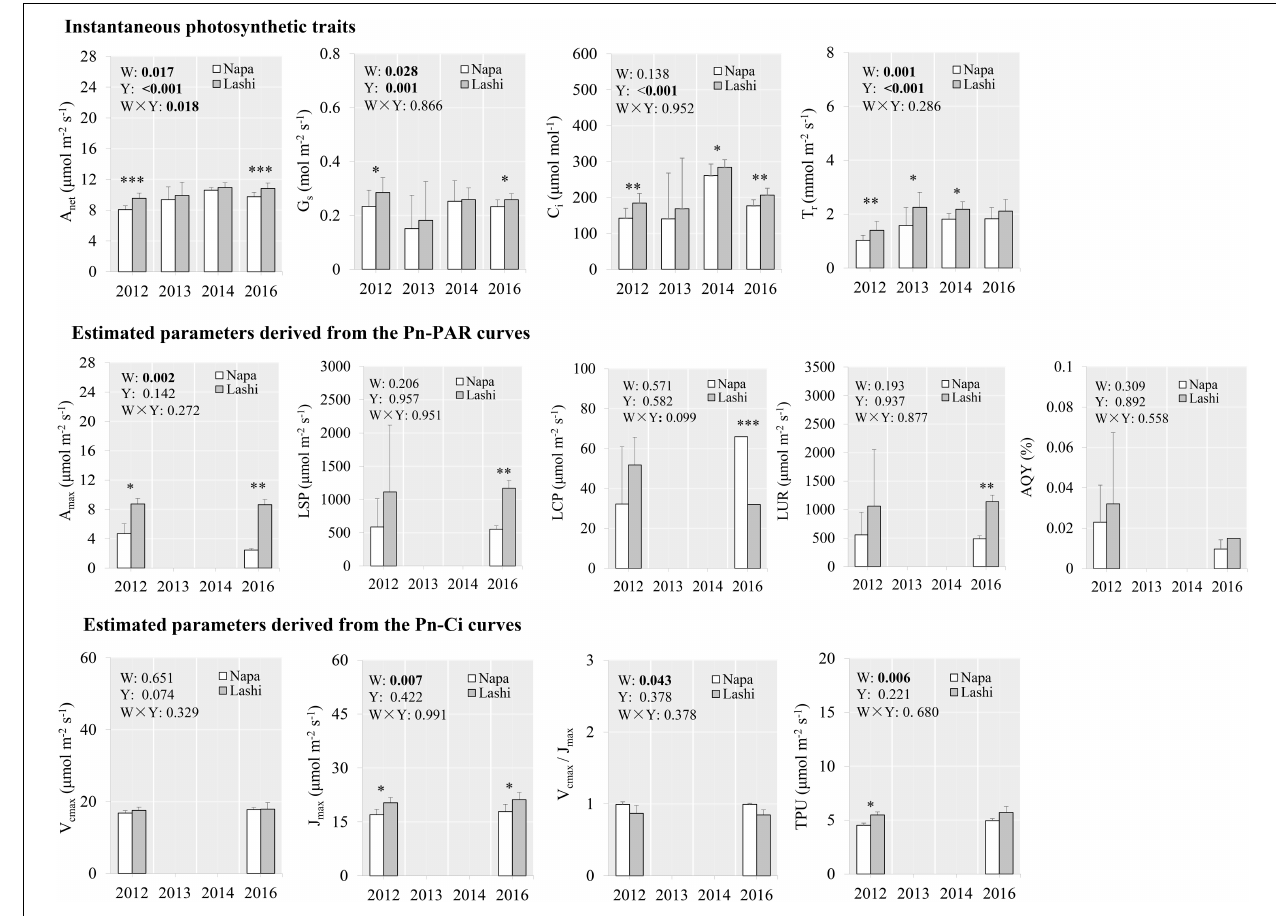
FIGURE 5 | Photosynthetic traits of S. tabernaemontani leaves between Lashi and Napa using the natural latitudinal gradient. Significance tests for warming ( W ), observed year ( Y ), and the interaction term ( W × Y ) under repeated-measures ANOVA are presented for each variable integrated across the different years ( p -values less than 0.05 are in bold). Within each year, variables that responded significantly to warming are indicated by asterisks ( ∗∗∗ p < 0.001; ∗∗ p < 0.01; ∗ p < 0.05). Error bars indicate standard deviations. P n -PAR and P n - C i curves were not determined in 2013 and 2014. See Figure 2 for descriptions of variables.